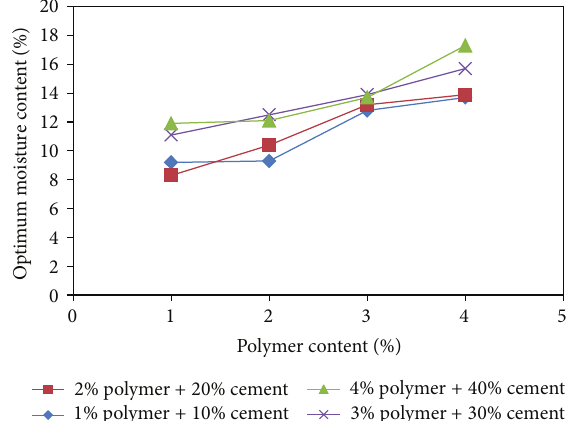
Figure 13: Effect of polymer content on OMC in wet conditions for 7